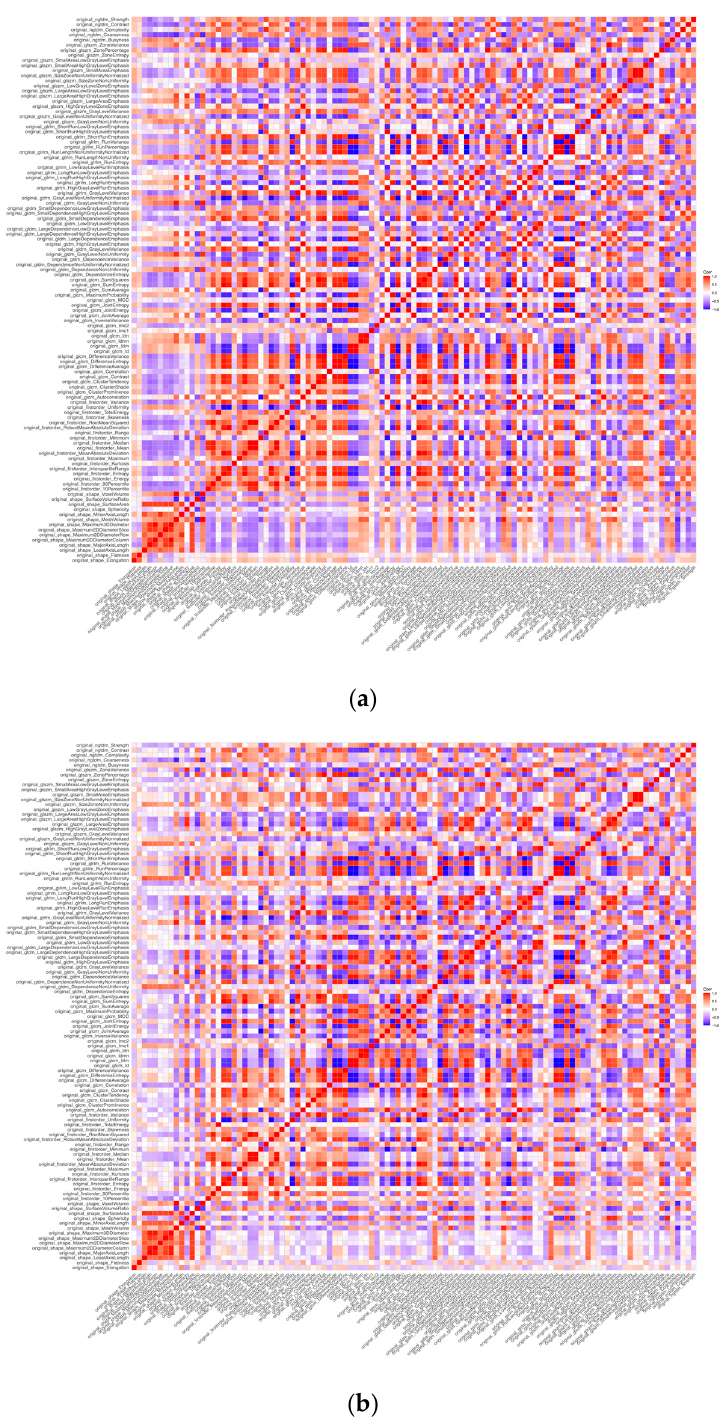
Figure 2. Correlation matrix of radiomics features extracted from myocardial segmentation. ( a ) Heatmap of myocardial radiomics features from energy-integrating CT (EICT) scans of 25 patients. ( b ) Heatmap of myocardial radiomics features from photon-counting CT (PCCT) scans of 25 patients.